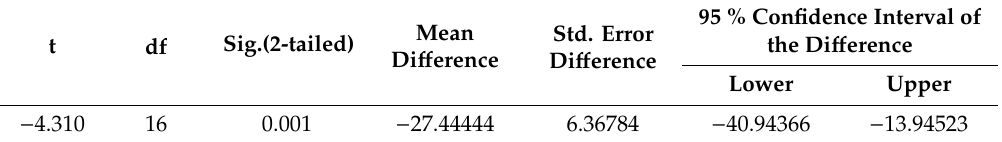
Table 12. T-test for E ffi ciency in determining VR and